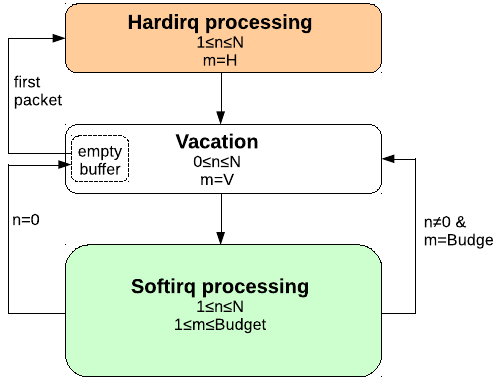
Figure 3. Diagram of processings and